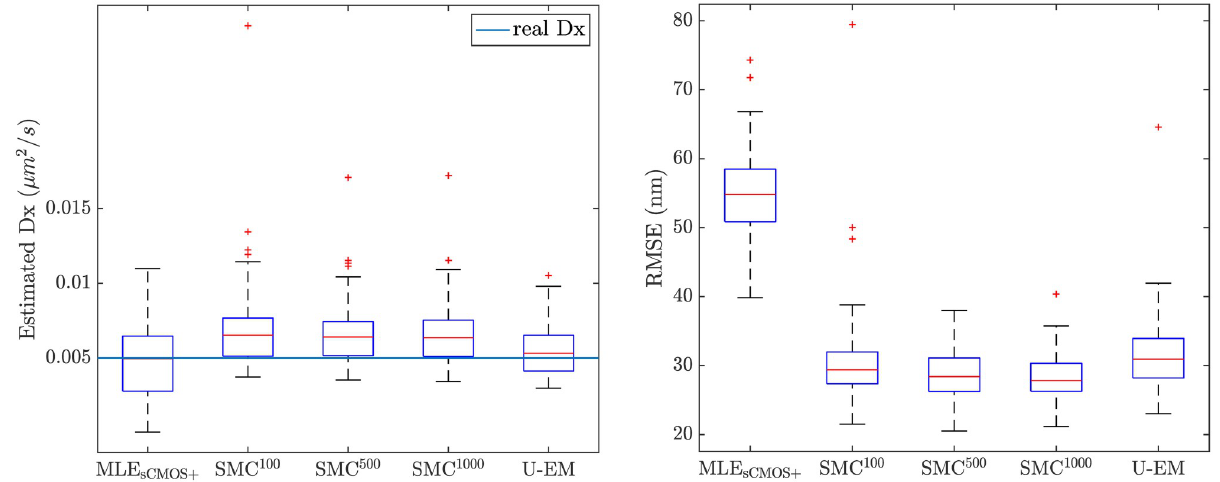
Fig 15. Estimation performance of different SPT methods on sCMOS camera model at G = 10, N bgd = 10.